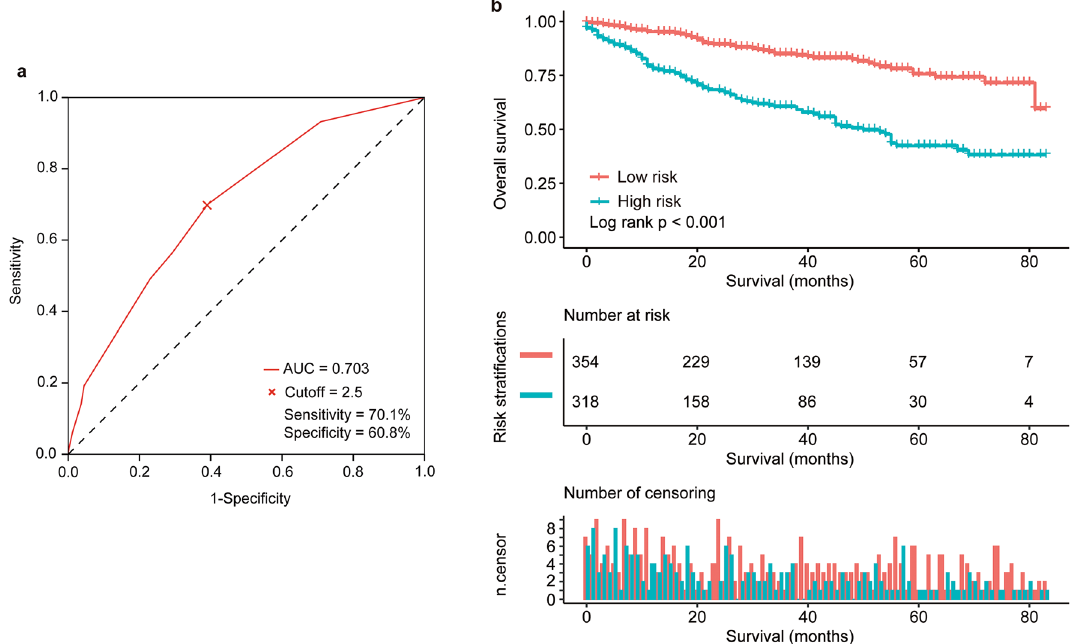
Figure 3. Distribution ‐ based cutoff optimization for risk score. ( a ) Receiver operating characteristic curve of risk scores; the optimal cutoff was assessed for the event of death. ( b ) Overall survival (OS) rates according to risk stratifications (low risk vs high risk, P < 0.001). Pictures show the number of subjects at risk in each group at 20-month increments. Pictures show the number of censoring in each group at 20-month